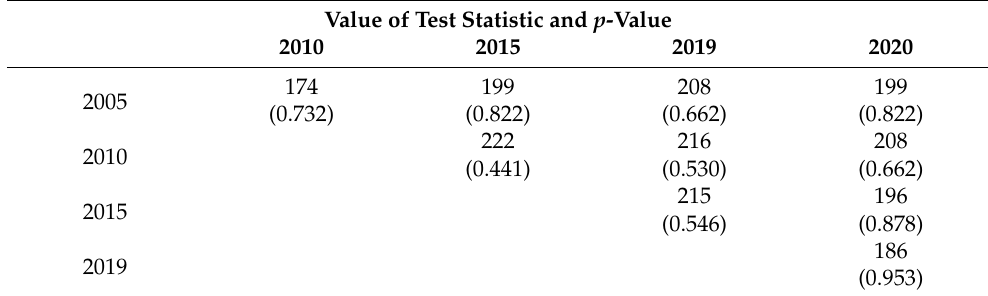
Table 7. Values of Wilcoxon rank ‐ sum test statistics.